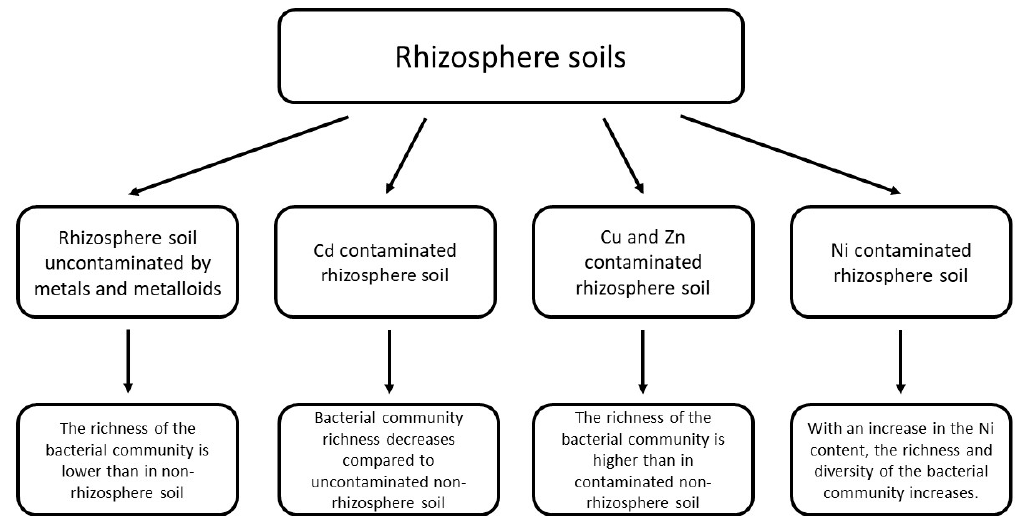
Figure 3. General effects of metals on rhizosphere soil bacterial community (according to the analyzed publications).